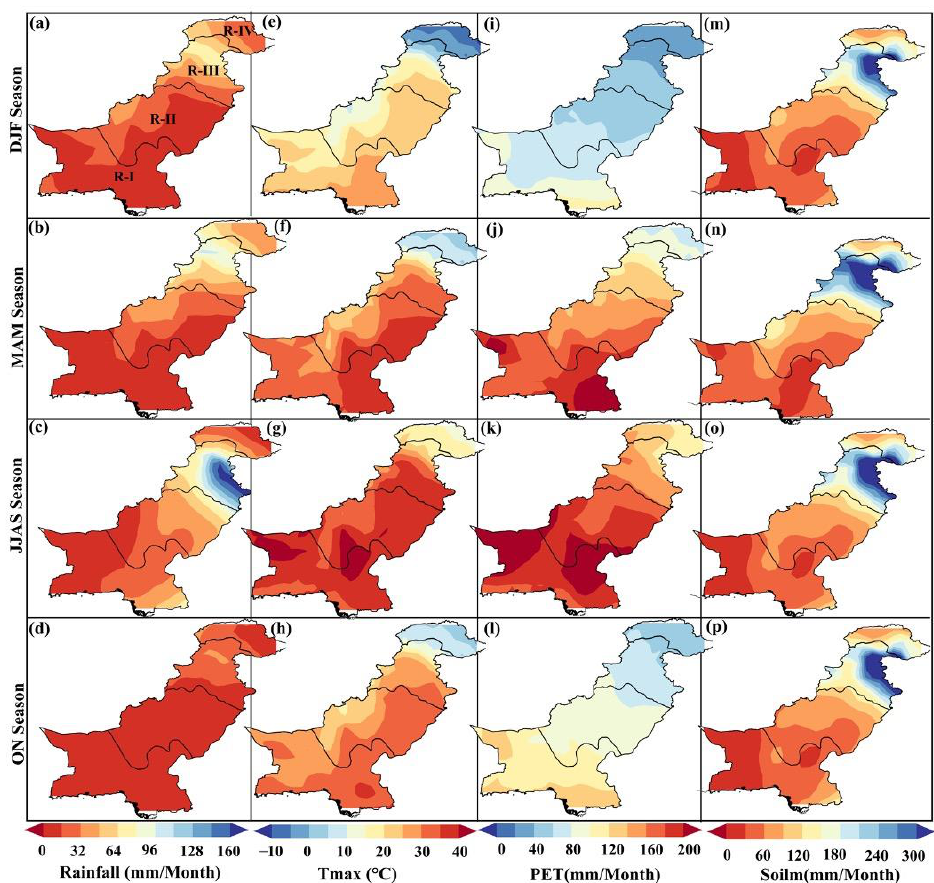
Figure 3. Spatial distribution of rainfall (mm/month) during the ( a ) DJF (December to February), ( b ) MAM (March to May), ( c ) JJAS (June to September), and ( d ) ON (October to November) Season over Pakistan for 1980 – 2018. Temperature (°C), potential evapotranspiration (PET; mm/month), and soil moisture (Soilm; mm/month) in four climate seasons are shown in ( e – h ), ( i – l ) and ( m – p ), respectively. Hyper-arid (R-I), arid (R-II), humid (R-III), and glacial (R-IV) regions are demarcated and named in ( a